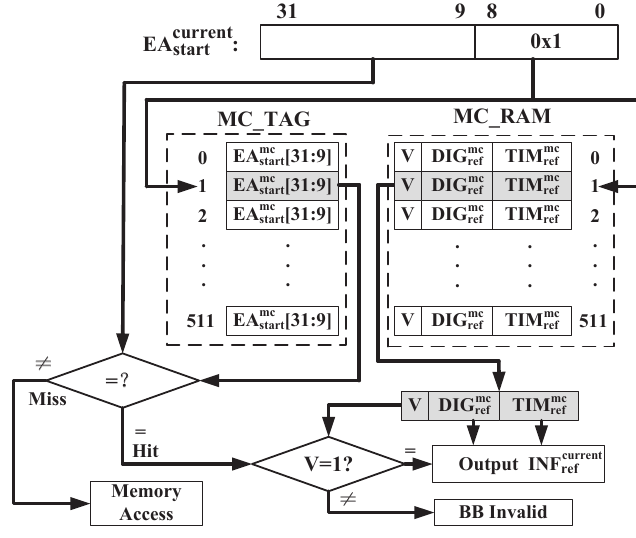
Figure 6. The structure of